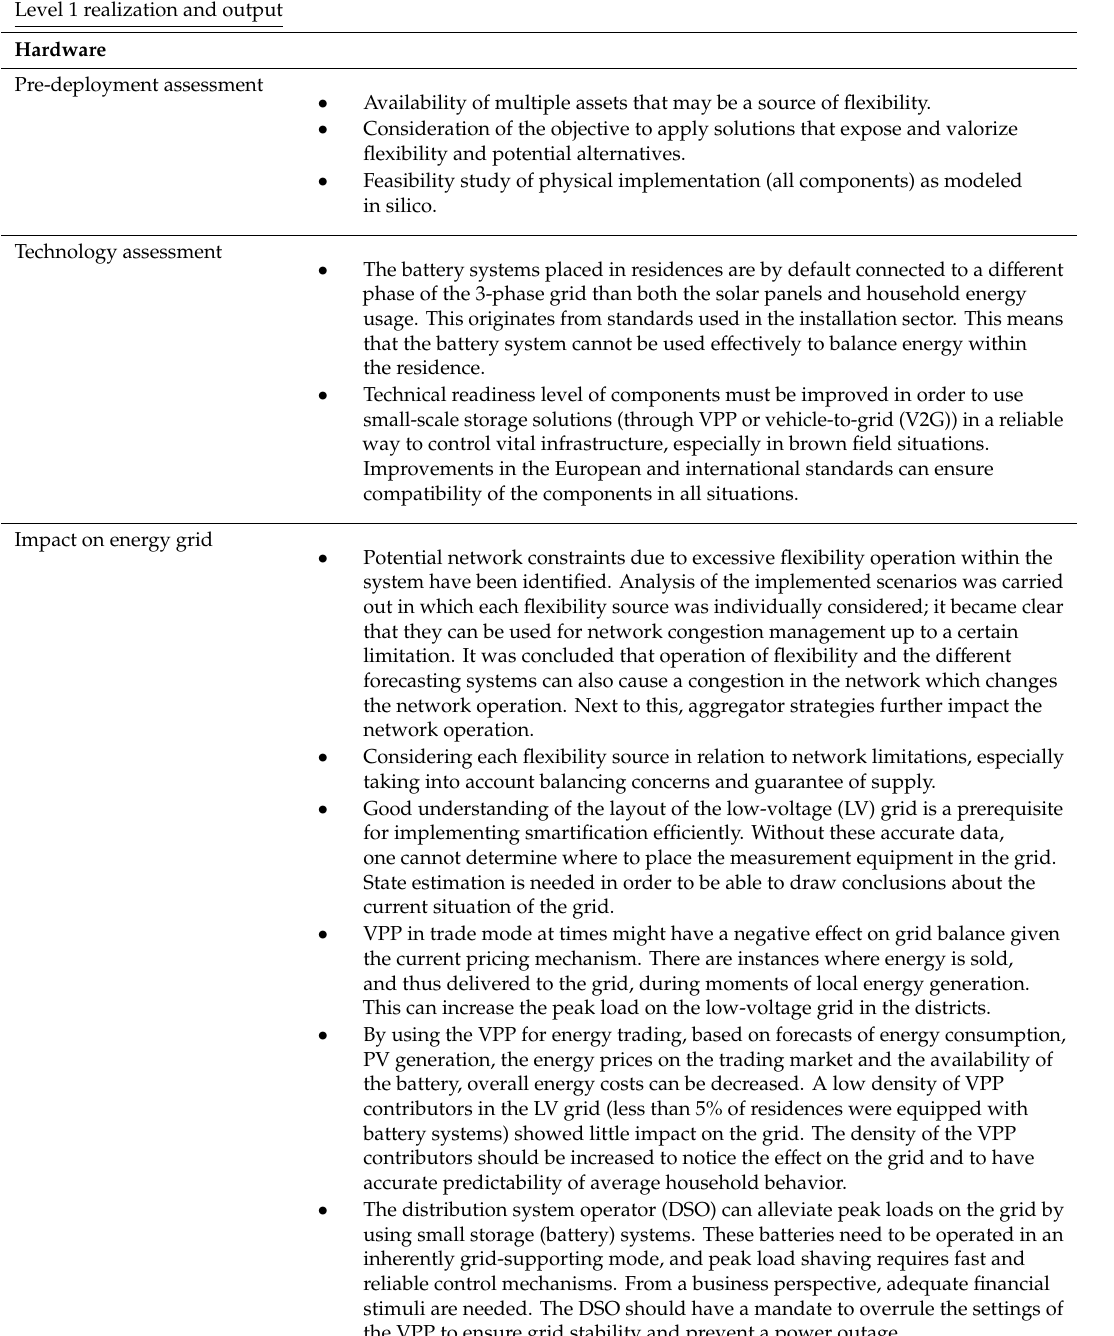
Table 2. Mapping